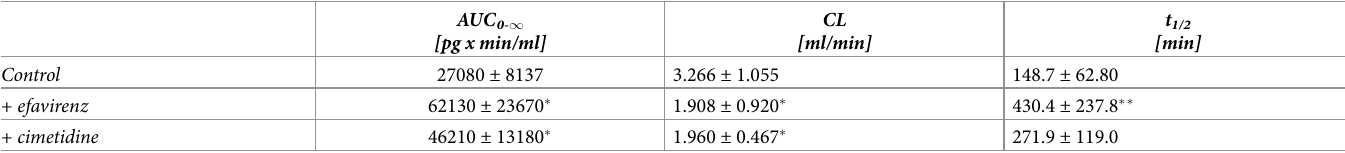
Data are presented as means ± SD (n = 5).